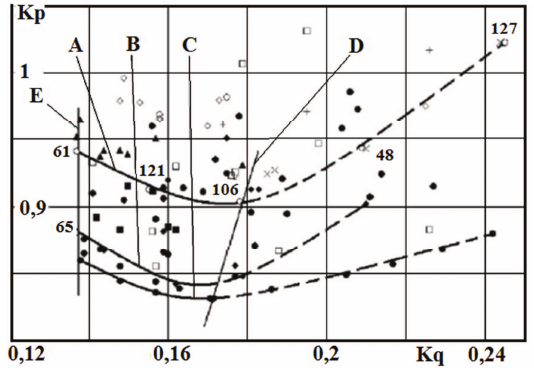
Fig. 3. Sampling points and compromise confidence curves on the criteria plane (Kp; Kq) In point № 61, seven parameters are located near the centre of the scanned area, two parameters assume the max- imum assumed values and two assume the minimum val- ues. In point № 106, nine out of twelve parameters are located in the centre, two acquire the minimum value and one acquires the maximum. In point № 121, the number of mean values is eight, two assume the minimum and two assume the maximum values. In the obtained number of solutions, there exists an isolated point № 65 (Fig. 3).